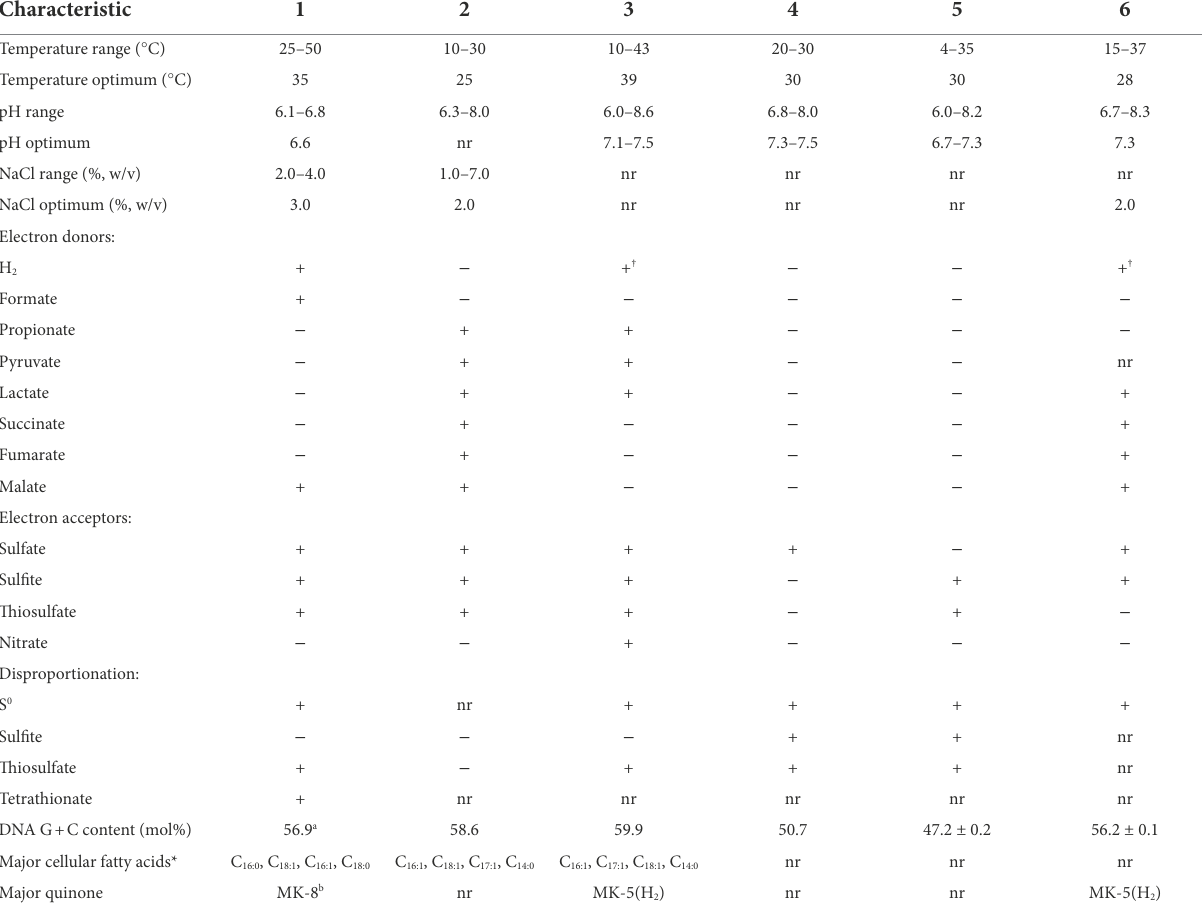
TABLE 1 Comparison of physiological characteristics of strain GF1 T with related genera of Desulfobulbaceae .